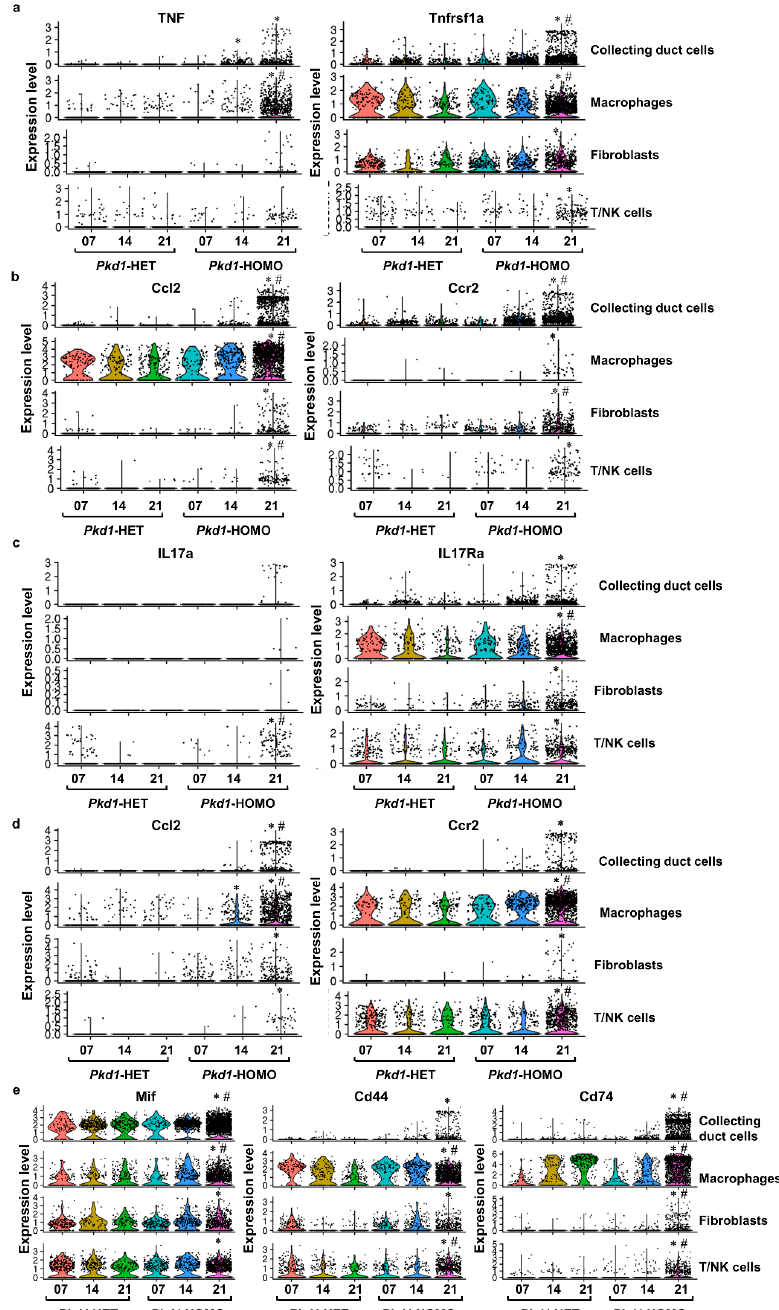
Figure 8. The expression of cytokines and their corresponding receptors was changed in collect- ing duct cells, macrophages, immune cells and fibroblasts. ( a ) Violin plots showing TNF and its receptor TNF RI’s dynamic expression in four types of cells during PKD progression. ( b ) Violin plots showing IL1b and its receptor IL1r1’s dynamic expression in four types of cells during PKD progression. ( c ) Violin plots showing IL17a and its receptor IL17Ra’s dynamic expression in four types of cells during PKD progression. ( d ) Violin plots showing CCL2 and its receptor Ccr2’s dy- namic expression in four types of cells during PKD progression. ( e ) Violin plots showing MIF and its receptors CD74 and CD44’s dynamic expression in four types of cells during PKD progression. * represents the comparison between Pkd1 HOMO kidneys and age-matched Pkd1 HET kidneys ( p < 0.05). # represents the comparison between Pkd1 HOMO 21 kidneys and Pkd1 HOMO 7 and 14 kidneys, respectively ( p < 0.05), as calculated by a one-way ANOVA